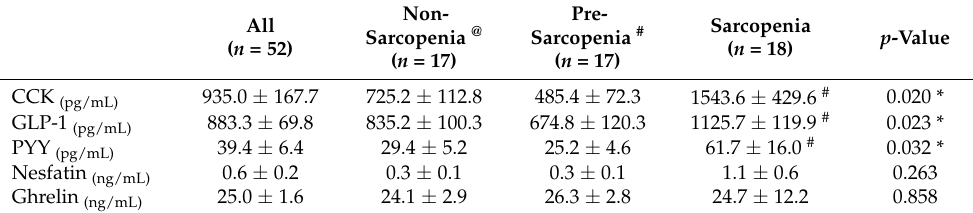
Table 3. Analysis of gastrointestinal hormones between groups. All ( n =